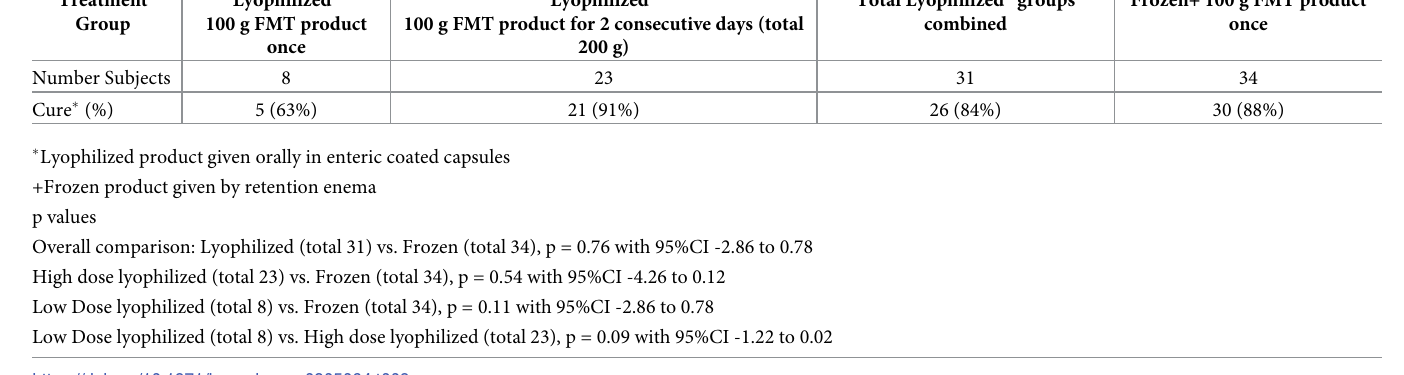
Table 3. Preliminary efficacy by treatment group in preventing CDI recurrence for 60 days after FMT. Treatment